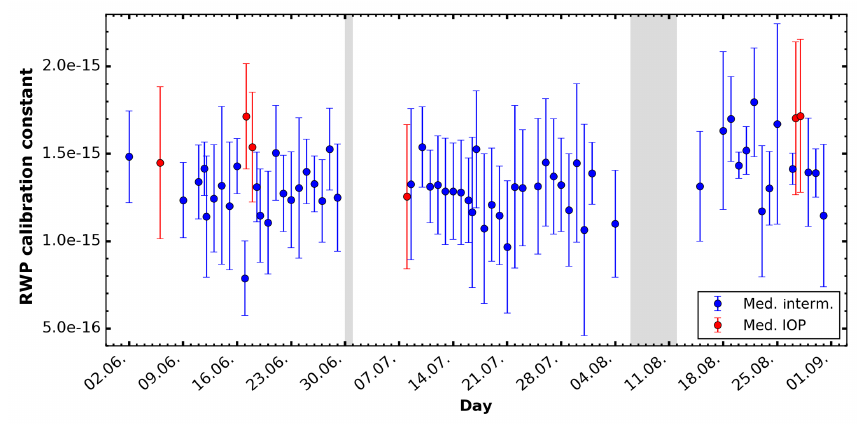
Figure 5. Daily median (dot) and the median absolute deviation (bar) of the RWP calibration for the whole campaign when appropriate conditions were present. The IOP settings are marked in red, the intermitting mode in blue. Measurement gaps due to maintenance are marked in grey. Note that the ordinate is linearly scaled.